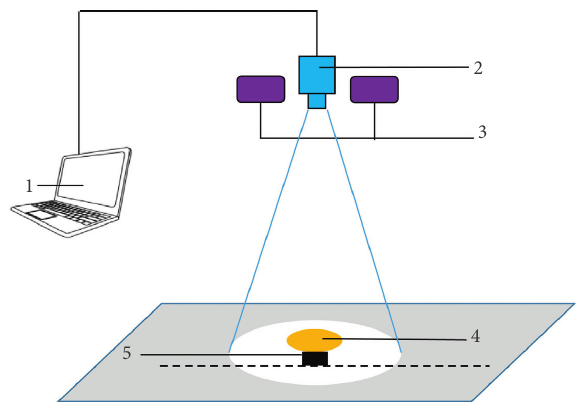
Figure 1: Machine vision system:1, computer; 2, camera system; 3, light source; 4, potato; 5, sample